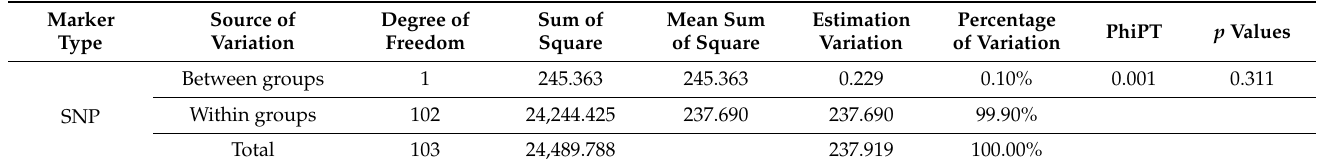
Table 5. AMOVA result between the subsets and the rest of the